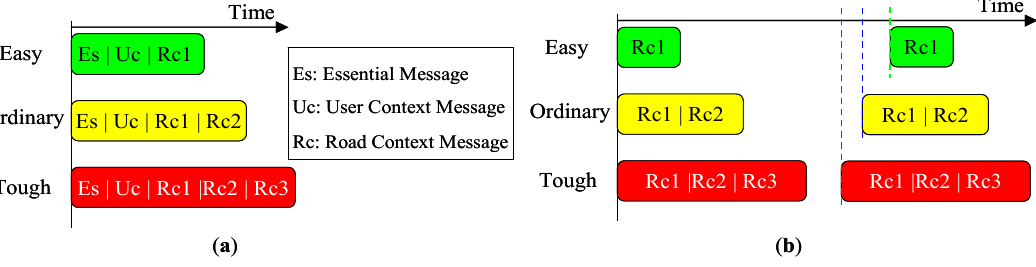
Figure 18. ( a ) Message set definition in different road contexts; ( b ) Delivery timing of road context message set in different road contexts. Table 2. Saliency of context messages in different road